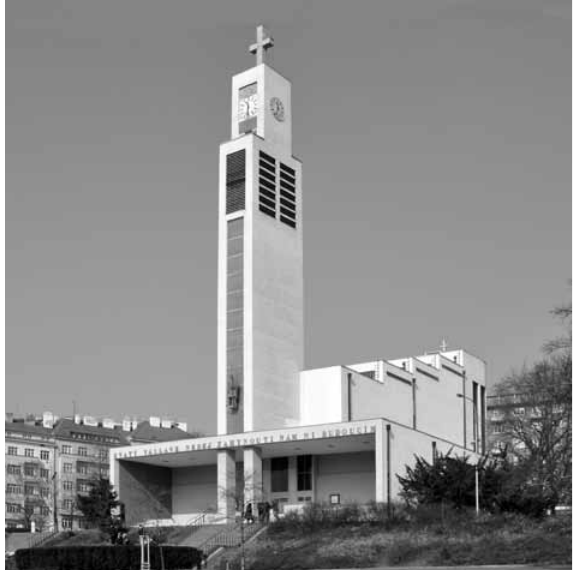
fig. 8. j. Gočár, Church of Saint Wenceslas in Prague,